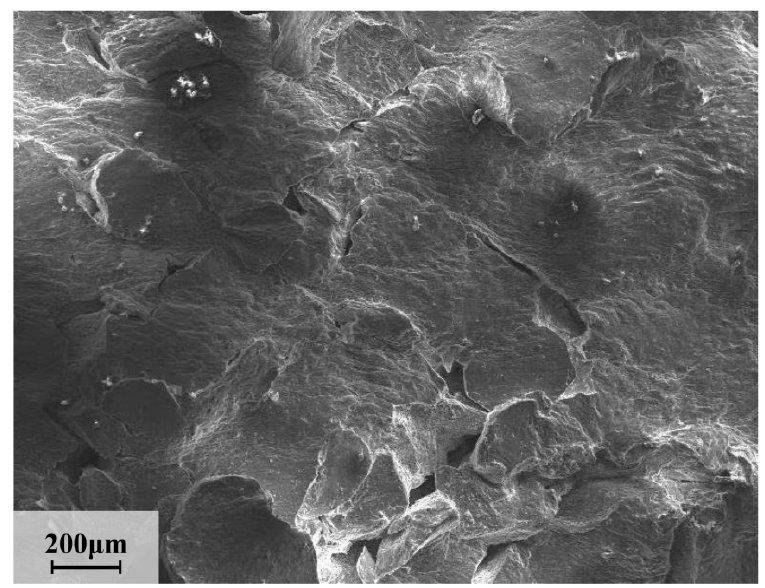
Figure 12. Microstructure of Mg − 2Sn − 1Ca alloy in 623 K/1 s − 1 thermal compression.